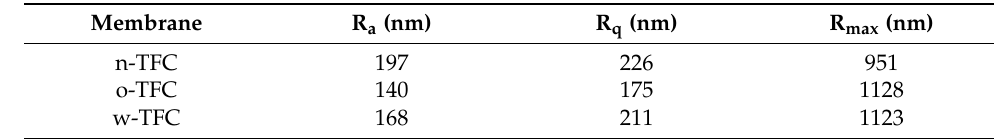
Figure 3. Atomic force microscopy (AFM) images of the nanofiber-supported TFC FO membranes prepared via different heat-curing methods. Table 1. Surface roughnesses of the polyamide (PA) active layers of the TFC FO membranes pre- pared via different heat-curing methods.